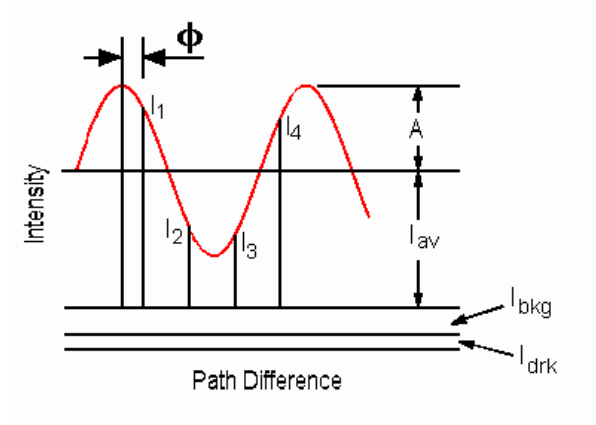
Fig. 1. Intensity vs. path difference for a single fringe, showing the four sampled intensities (I1...I4), the average signal corrected for dark current and background ( I DB ), the apparent amplitude ( A 0 ), the background signal ( I bkg ), and dark signal ( I drk ).